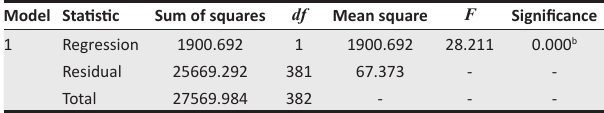
TABLE 5: Analysis of variance.